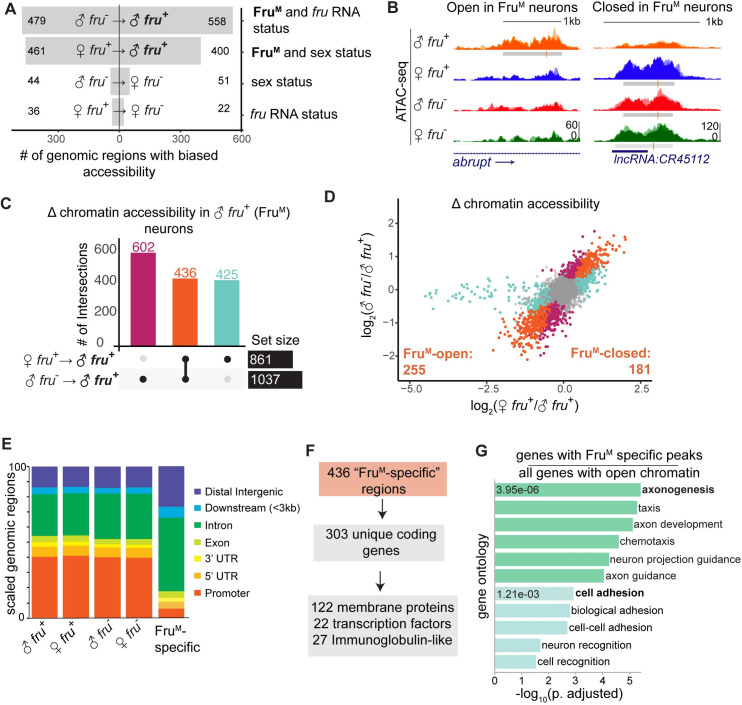
Chromatin changes downstream of FruM are near genes involved in neuronal projection and synaptic matching.A. Number of differentially accessible peaks between different sample comparisons at FDR<0.05. A “biased” region indicates a region which is relatively more open in a given comparison. Labels at right describe how compared conditions differ. B. Examples of peaks with increased (left) and decreased (right) accessibility specific to FruM neurons. C. UpSet plot showing intersection of DiffBind results at FDR <0.05 from male versus female fru+ neurons (861 sites) and male fru+ versus fru- neurons (1037 sites). D. Distribution of fold change between the binary comparisons shown in (C). Each point is a peak. Points are colored according to their status in (C). All peaks that are differentially accessible in both comparisons vary in the same direction in both comparisons. Tail of aqua points at left represent dosage compensation signals from the X chromosome. E. Distribution of peak locations for all peaks versus FruM-specific peaks. F. 436 FruM-specific peaks are located near 303 unique genes, which are enriched for the gene categories noted. G. GO analysis using gProfiler of the 303 genes shown in Fig 4F. We include only terms with <1000 members. Genes with FruM-specific annotated peaks were used as input gene lists, and all genes with peaks were used as background. Green terms relate to axonogenesis and teal to adhesion.